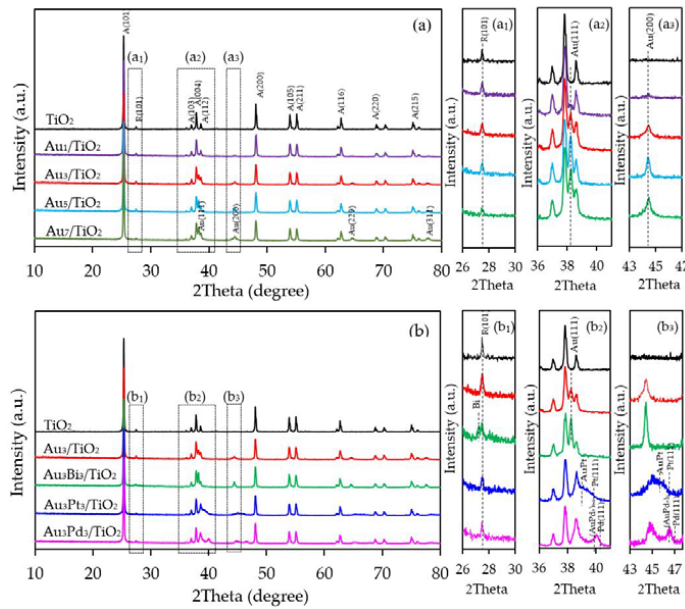
Figure 1. Representative X-ray diffraction (XRD) patterns of the ( a ) Au x /TiO 2 and ( b ) Au 3 M 3 /TiO 2 Figure photocatalysts.